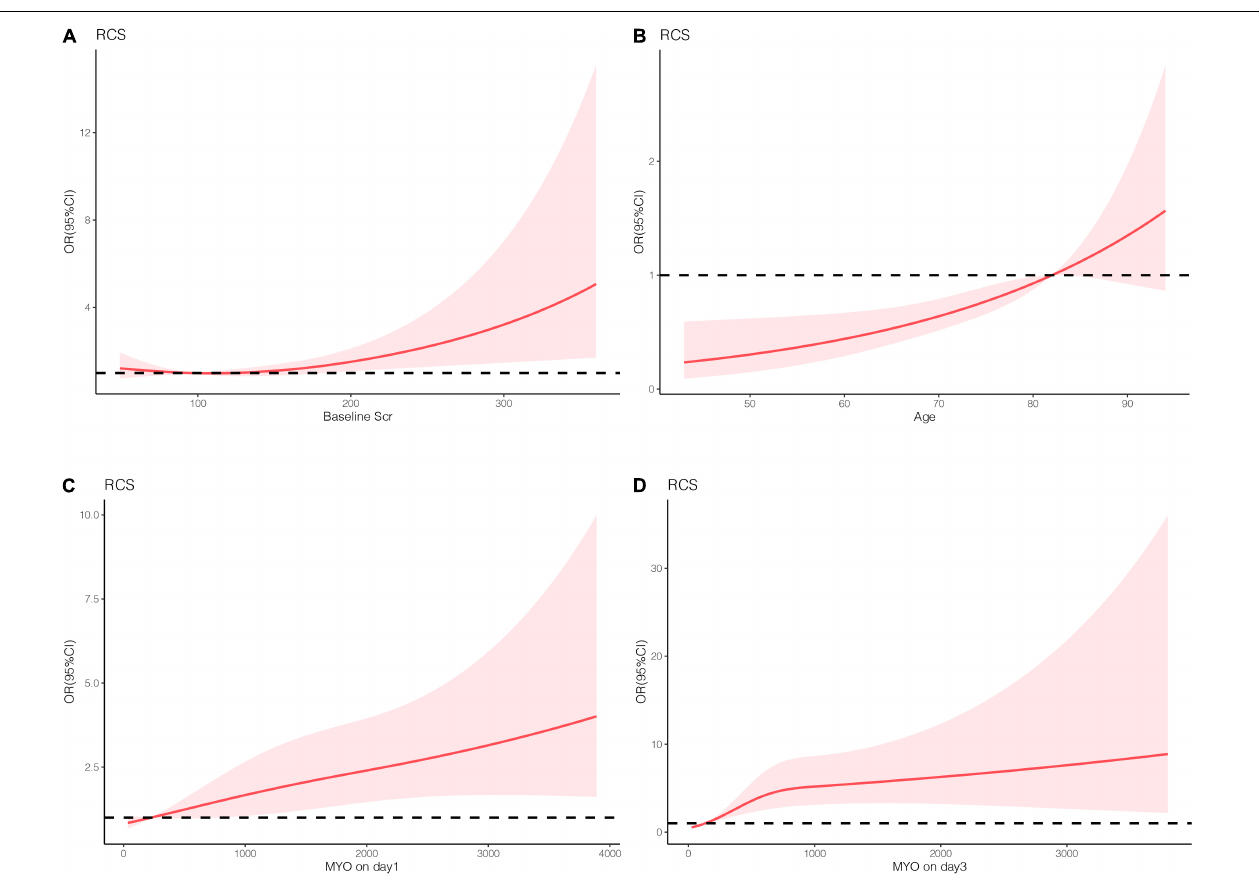
FIGURE 2 | The linear analysis of numeric variables. (A) Basic serum creatinine. (B) Age. (C) Serum MYO levels on day 1. (D) Serum MYO levels on day 3.